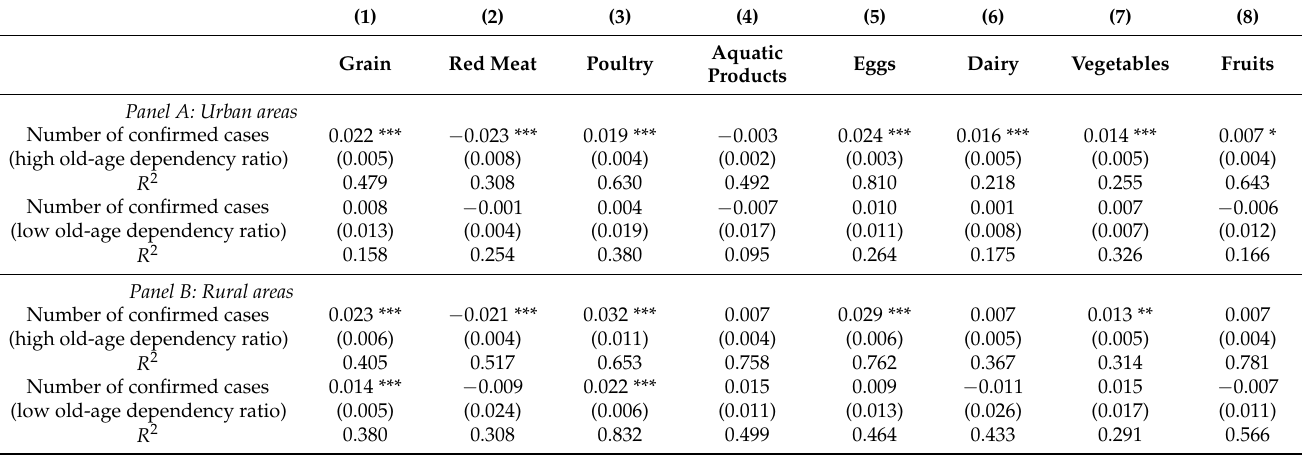
were more salient for regions with low illiteracy rates in comparison with those with high illiteracy rates. Table 4. Impacts of COVID-19 on urban and rural dietary consumption: heterogeneity by old-age dependency ratio.